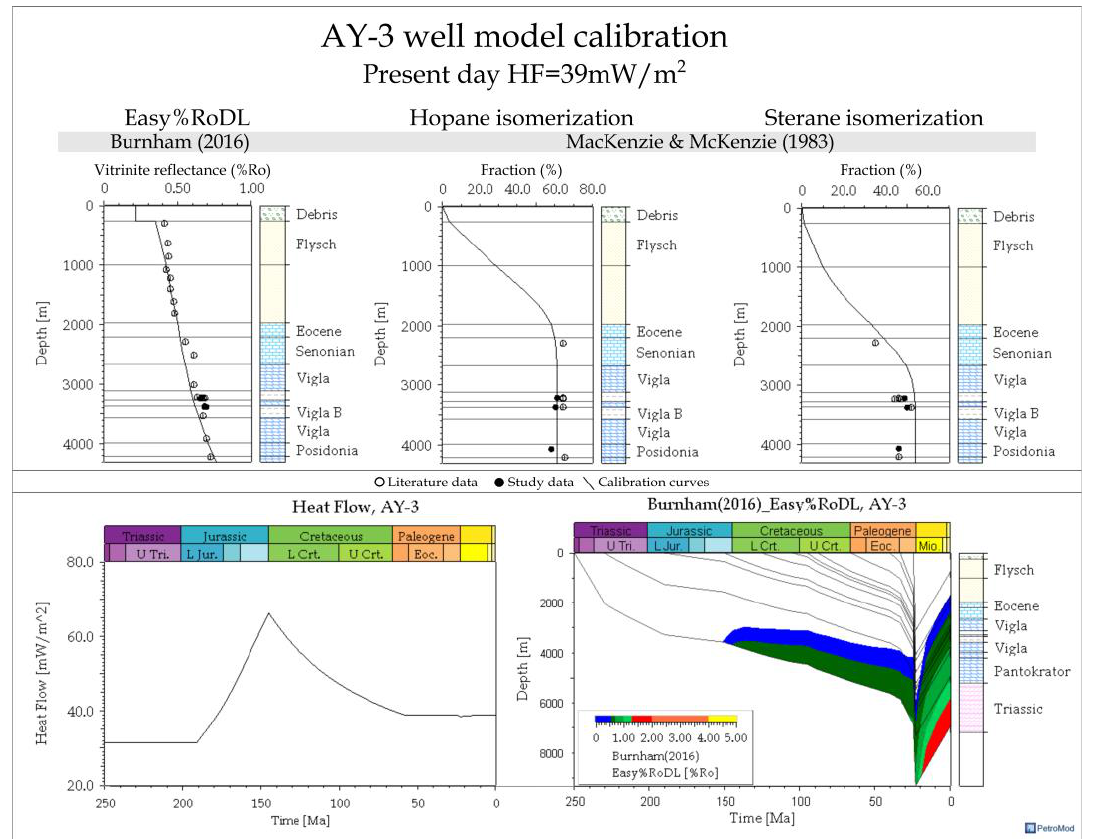
Figure 8. Burial and time plots of the AY-3 well. Top row, from left to right: left: Vitrinite reflectance calibration curve using the Easy %RoDL model of Burnham [67]; middle: Hopane isomerization ratio (C32 (%) 22S/(22S + 22R)) calibration curve with activation energy E = 21.5 kcal/mol, frequency factor A = 0e 25 /Ma and hopane isomerization ratio equal to 1.56, based on MacKenzie & McKenzie [78], and right: Sterane isomerization ratio (C29 (%) 20S/(20S + 20R)) curve with E = 21.5 kcal/mol, A = 0e 25 /Ma and hopane isomerization ratio equal to 1.17, based on [78]. Bottom row left: HF time trend based on [71] utilizing a present-day HF of 39mW/m 2 and right: burial history plot of the AY-3 incorporating the Easy %RoDL model [67] and a kerogen type I for the Vigla shales, following the Pepper and Corvi model [81].